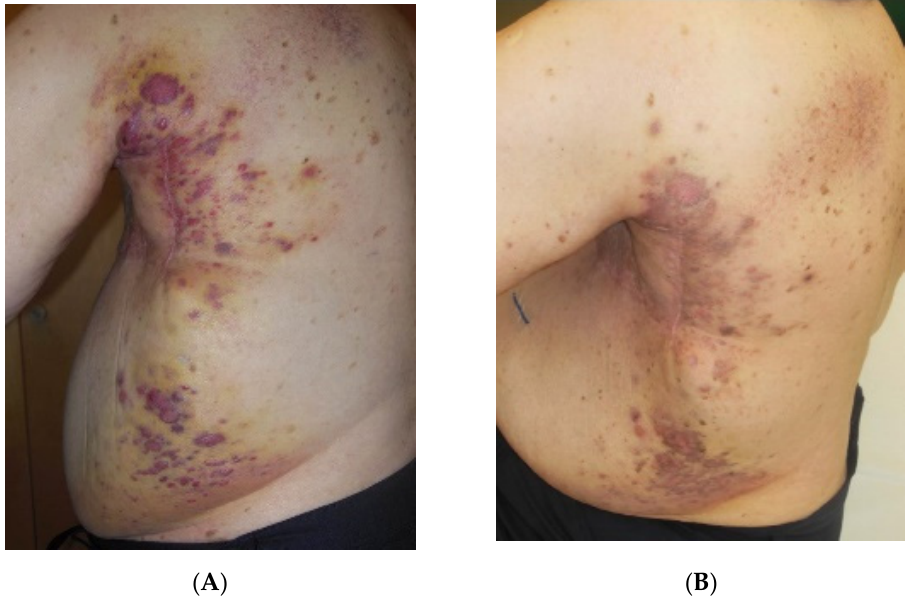
Figure 5. Successive documentation of Patient No. 9: ( A ) 1st consultation (February 2017). Recurrent RAASB with extension to the back growing along surgical scar (reconstruction of left chest wall). Size Class IV b. Palliative situation. ( B ) 3 weeks after wIRA-hyperthermia + 5 × 4 Gy (March 2017). PR in the treatment fields. Relief of pain.